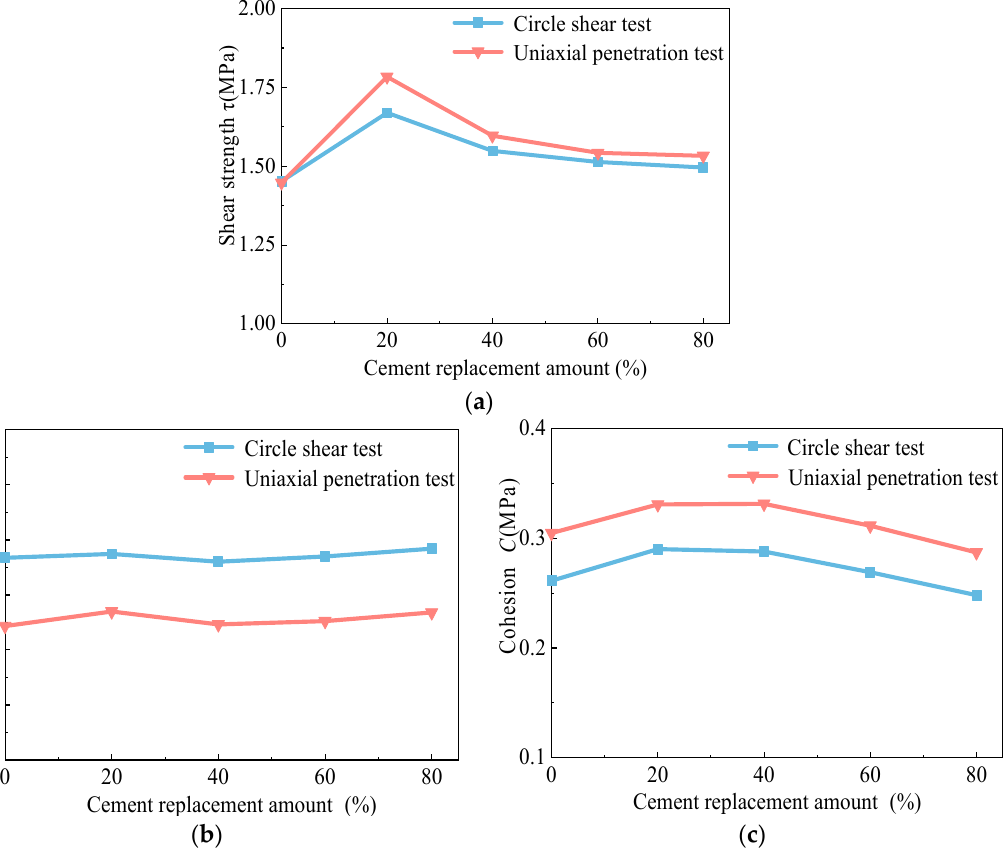
Figure 12. Influence of cement replacement amount on Shear strength, internal friction angle, and cohesion. ( a ) Shear strength; ( b ) Internal friction angle; ( c ) Cohesion.